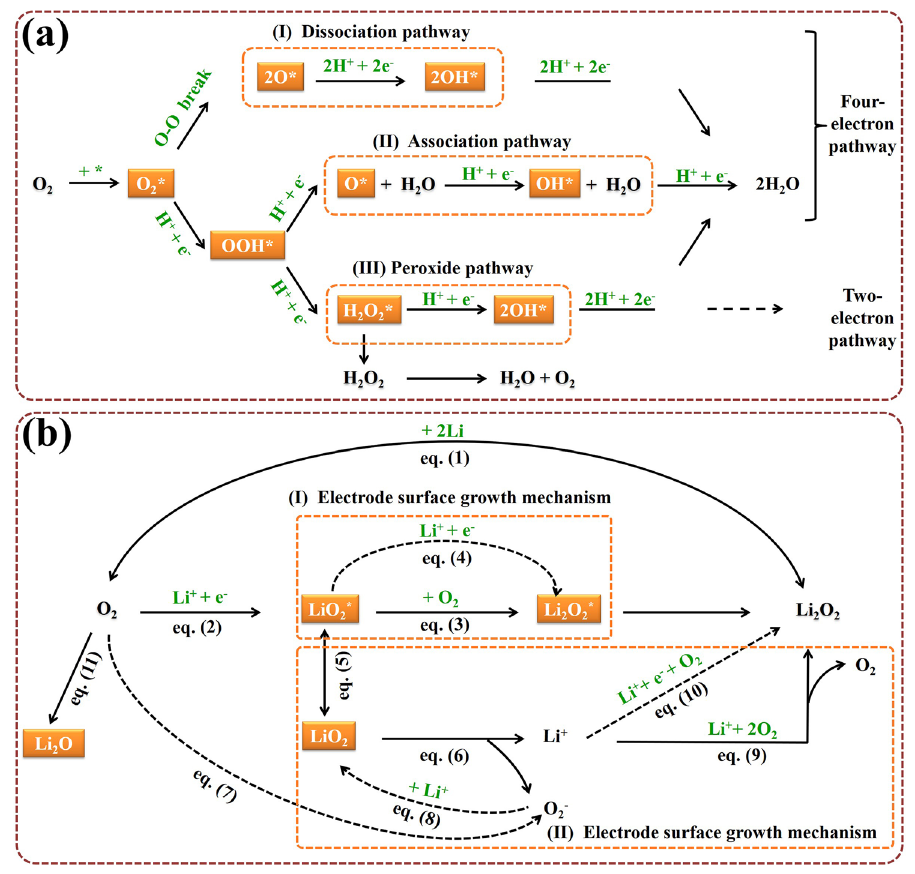
Fig. 2 a ORR mechanism of PEMFC (one kind of fuel cell), and b Li 2 O 2 battery (one kind of metal–O 2 /air battery), both with reaction path- ways in the orange dash frames, with intermediates in orange solid